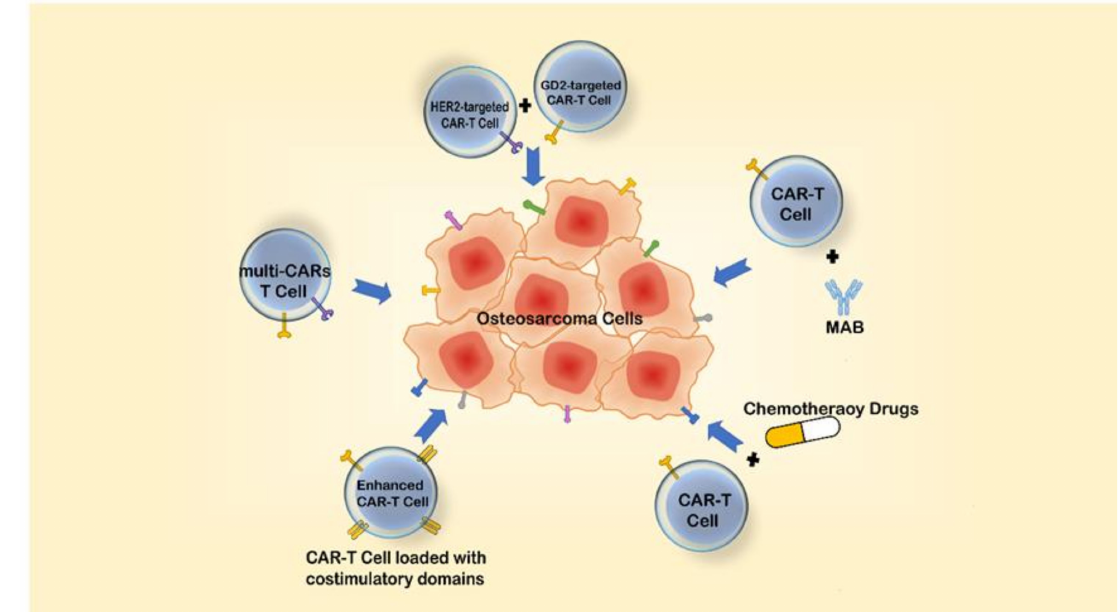
Figure 3. Solutions to enhance the efficacy of CAR-T cell